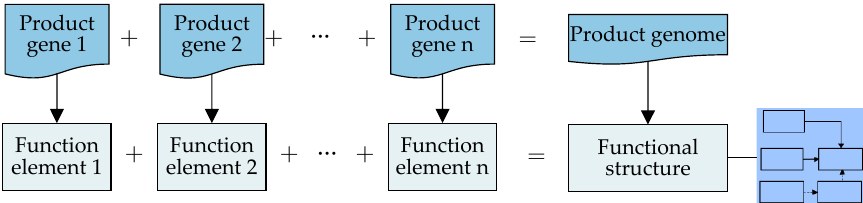
Figure 13. Transcription process of the product genome.